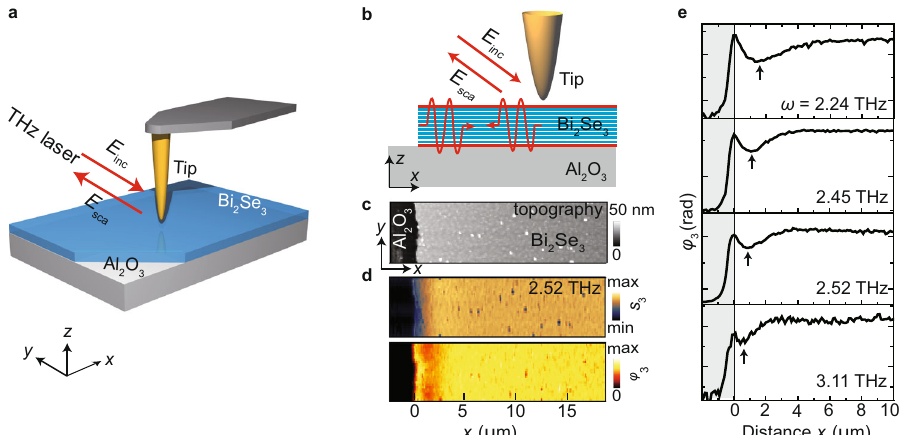
Fig. 1 THz s-SNOM imaging polaritons in Bi 2 Se 3 . a Schematic of the THz s-SNOM. A parabolic mirror focuses a THz beam onto the apex of an AFM tip. The tip-scattered THz fi eld is collected and recorded interferometrically as function of tip position, simultaneously with topography. b Illustration of mapping polaritons (indicated by red sine waves). E inc and E sca denote the electric fi eld of the incident and tip-scattered radiation. c Topography image of a 25-nm-thick Bi 2 Se 3 fi lm on Al 2 O 3 and d simultaneously recorded amplitude and phase images at a frequency of 2.52 THz. e Near- fi eld phase line pro fi les of